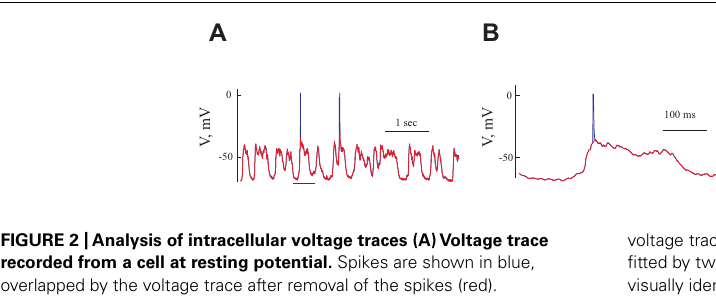
FIGURE 2 |Analysis of intracellular voltage traces (A)Voltage trace recorded from a cell at resting potential. Spikes are shown in blue, overlapped by the voltage trace after removal of the spikes (red). (B) Expansion of 500 ms from (A) (bounded by the blue horizontal line in A ). (C) The distribution of membrane voltage (black line) calculated from the